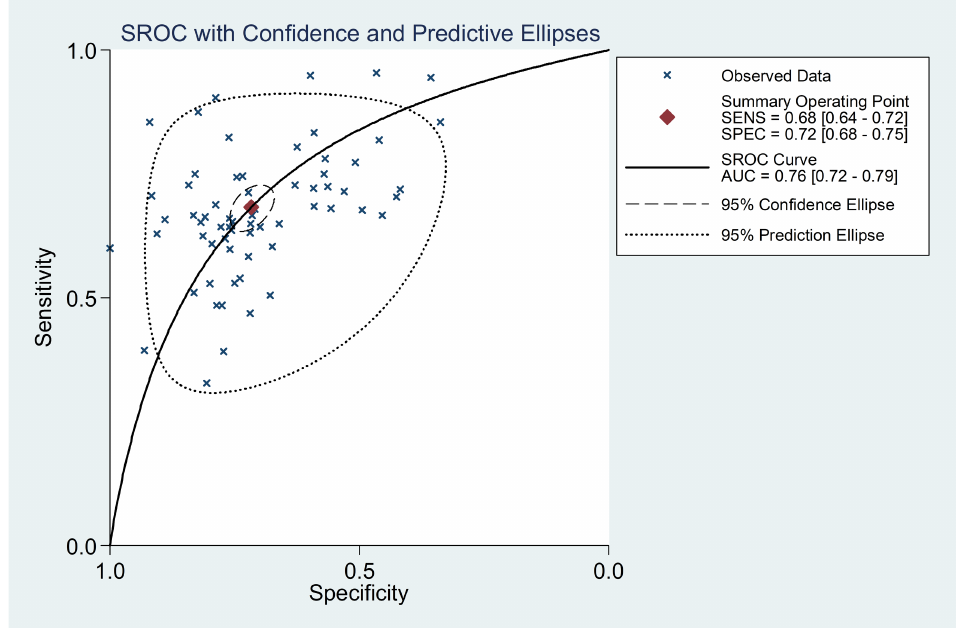
Figure 4 - Summary receiver operating characteristic curves of PCA3 for the diagnosis of PCa. Each solid circle represents an eligible study. The size of solid circle represents the sample size of each eligible study. The overall diagnostic efficiency is summarized by the regression